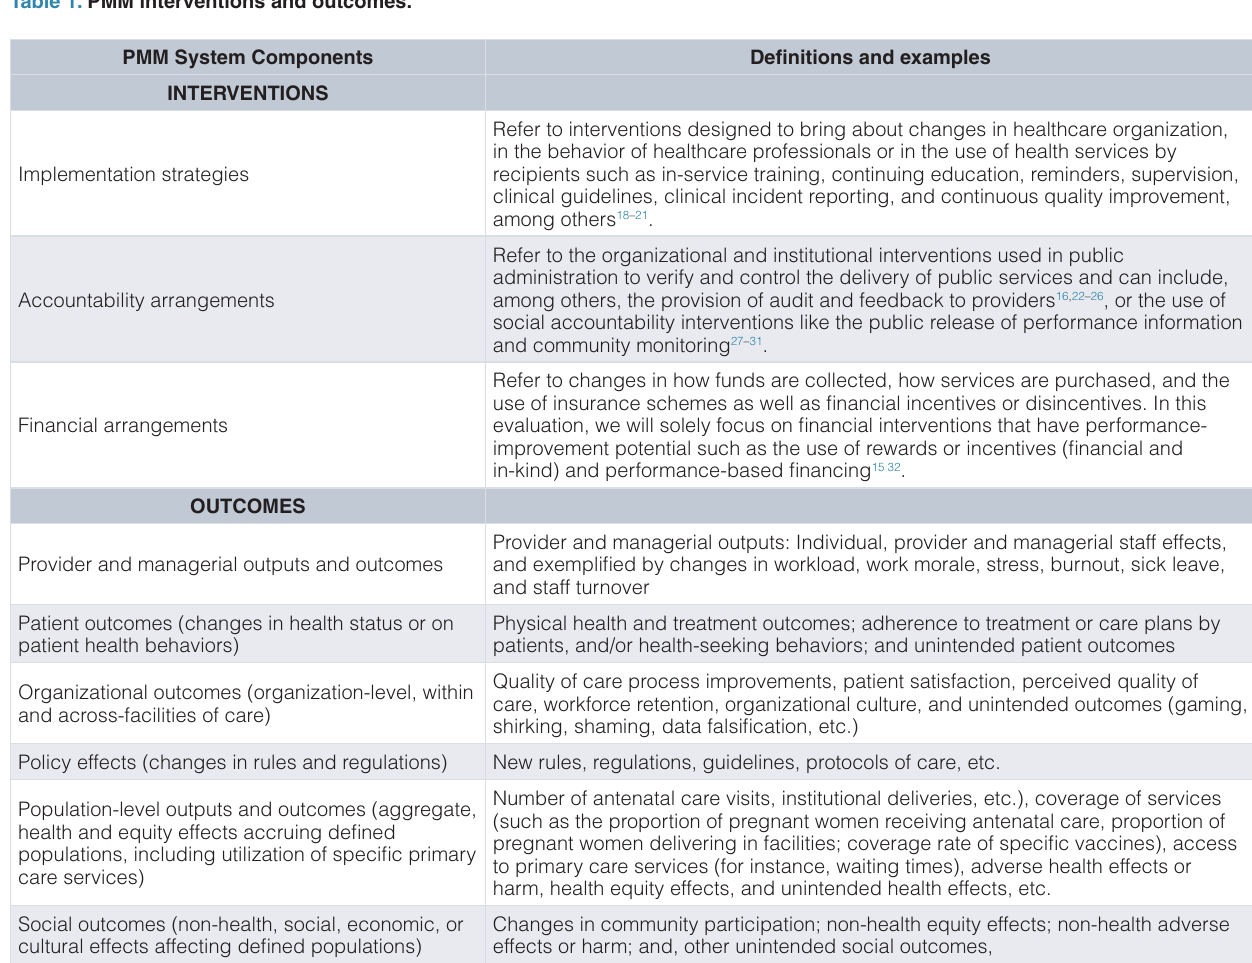
Table 1. PMM interventions and